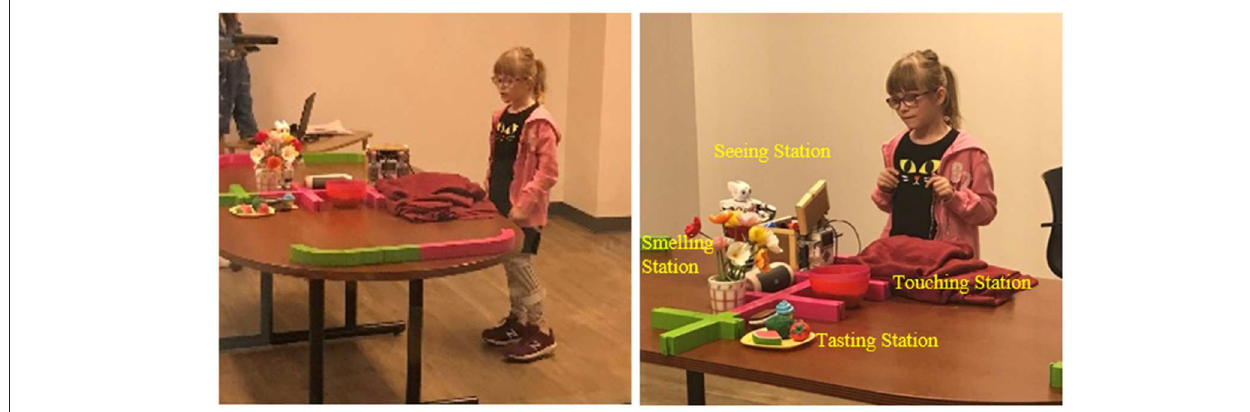
FIGURE 1 | Station setup for the sensory maze game (the child’s photo rights reserved).